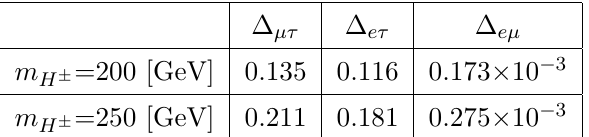
(cid:26) (cid:23) = V (cid:23) (cid:26) (cid:23) at 90% CL in the cases with m f j ( (cid:26) (cid:23) ) lj ( (cid:26) (cid:23) ) l 0 j (cid:3) j is de(cid:12)ned. f f j